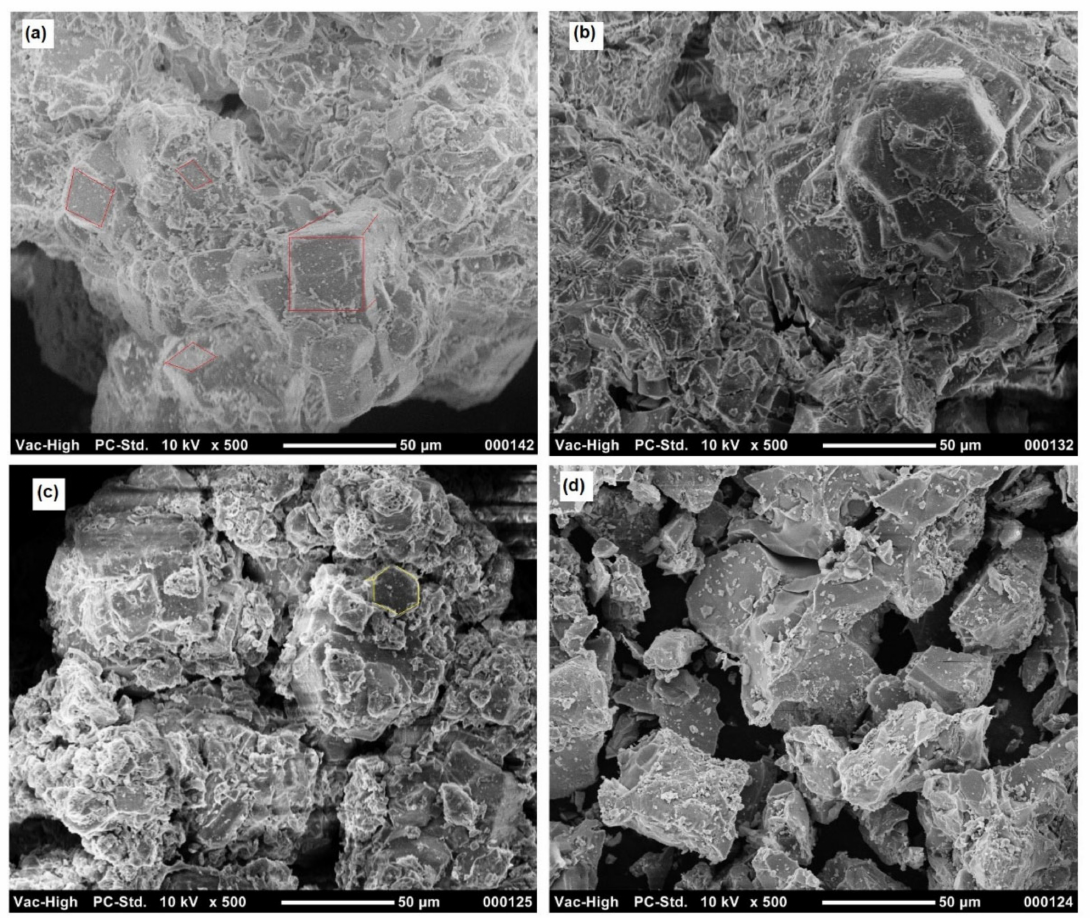
Figure 2. H 2 -TPR profiles of 5 wt.% (a) Ni 2 P/ ɣ -Al 2 O 3 , (b) CoP/ ɣ -Al 2 O 3 , and (c) Fe 2 P/ ɣ -Al 2 O 3 supported catalysts.